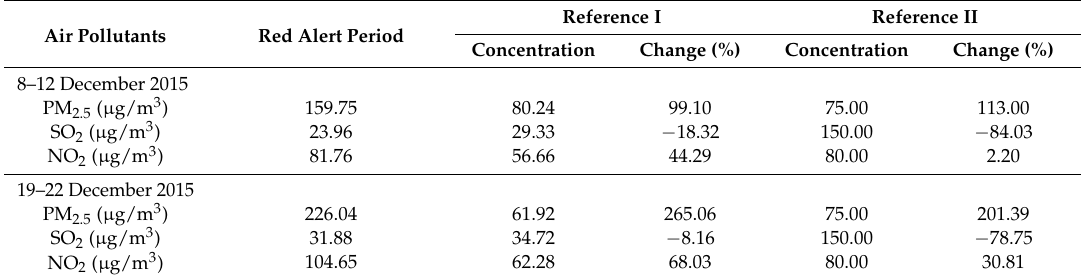
Table 1. Comparison of the mean PM 2.5 concentrations between the red alert and reference periods in the six urban districts of Beijing,